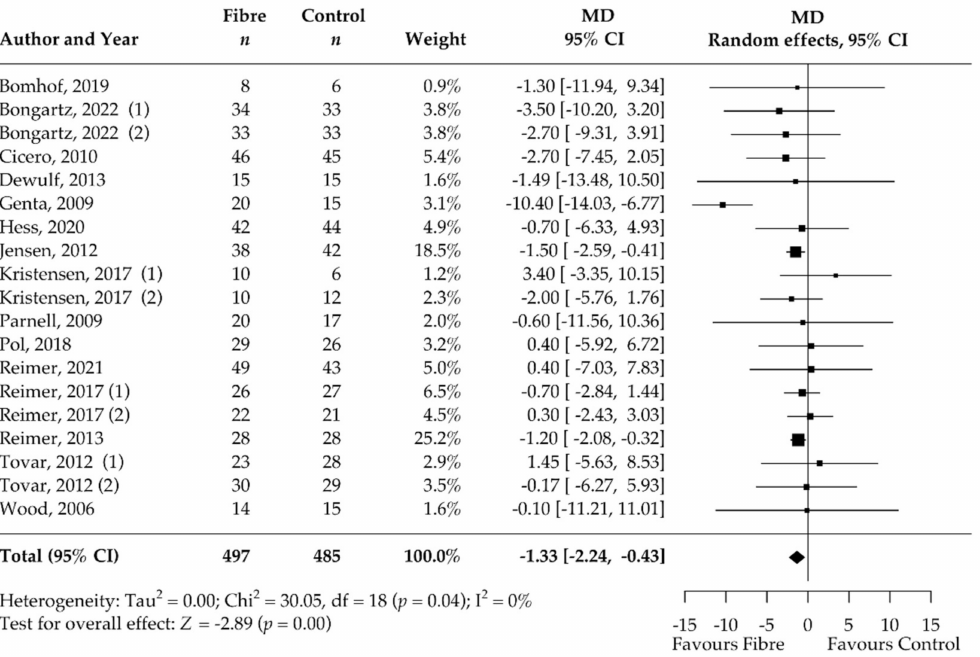
Figure 5. Isolated soluble dietary fibre supplementation significantly decreased waist circumference [cm] in overweight and obese people ( n = 949). Black rectangles represent MD for each study; the size of the rectangle is proportional to the weight of the study for the pooled effect. Horizontal lines indicate 95% CI. The black diamond summarises the pooled MD data. MD = mean difference; (1)/(2) indicate cohort 1 and 2 of study